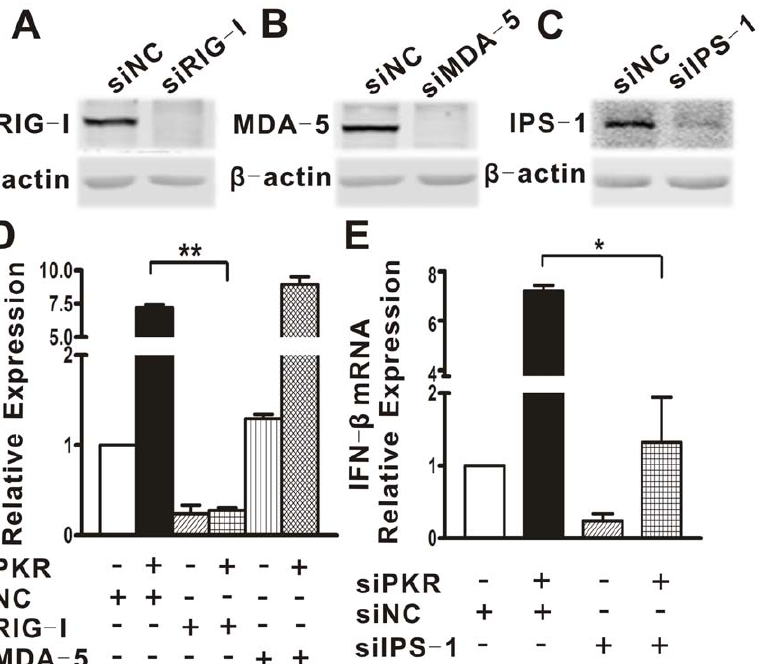
Figure 3. The IFN induction mediated PKR knockdown was dependent on RIG-I and IPS-1, but not MDA-5. A549 cells were transfected with siRNA against RIG-I (siRIG-I), MDA-5 (siMDA-5) or IPS-1 (siIPS-1). Protein levels of RIG-I (A), MDA-5 (B) and IPS-I (C) were detected by Western blot. A549 cells were cotransfected with siRIG-I, siMDA-5 or siIPS-1 together with siPKR1 or siNC for 48 h followed by DENV2 infection (D, E). Total cellular RNA was analyzed for IFN- b using real-time PCR and normalized to that of GAPDH in each sample. Data are shown as the mean 6 SEM and represent at least three independent experiments. *p , 0.05, **p , 0.01. cells (Table 1), validating that these cell lines are permissive to DENV replication. Next, A549 cells were transfected with siPKR1, siRIG-I and siIPS-1, followed by DENV2 infection.